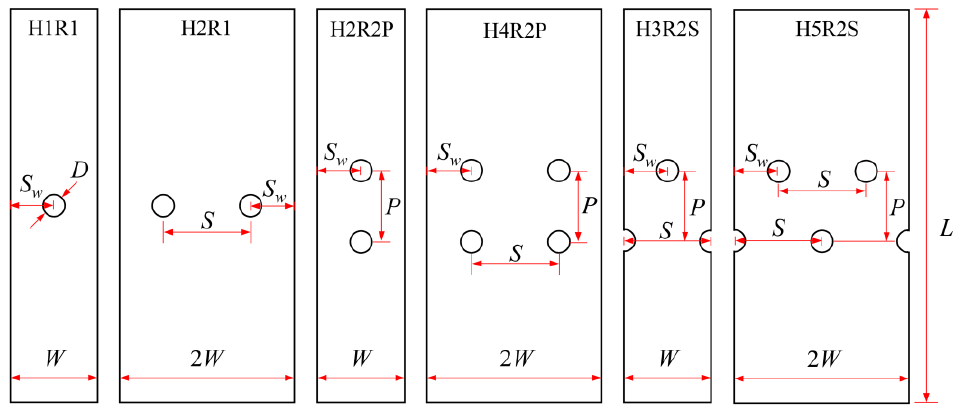
Figure 3. Typical joint configurations: ( a ) holes arranged in one row; ( b ) holes arranged in two rows with parallel form; ( c ) holes arranged in two rows with staggered form.